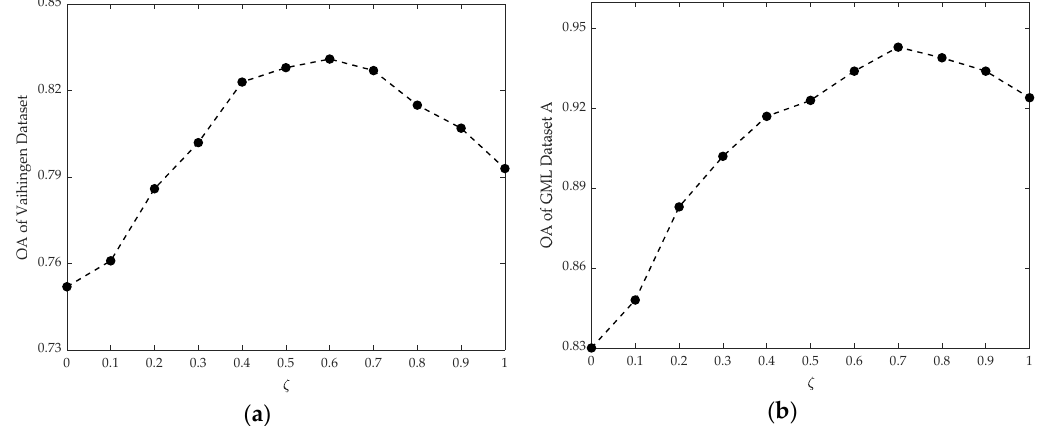
ζ Figure 17. ( a ) The trends of the OA with parameter in the Vaihingen Dataset; ( b ) the trends of Figure 17. ( a ) The trends of the OA with parameter ζ in the Vaihingen Dataset; ( b ) the trends of the OA ζ with parameter ζ in the GML Dataset in the GML Dataset A. the OA with parameter